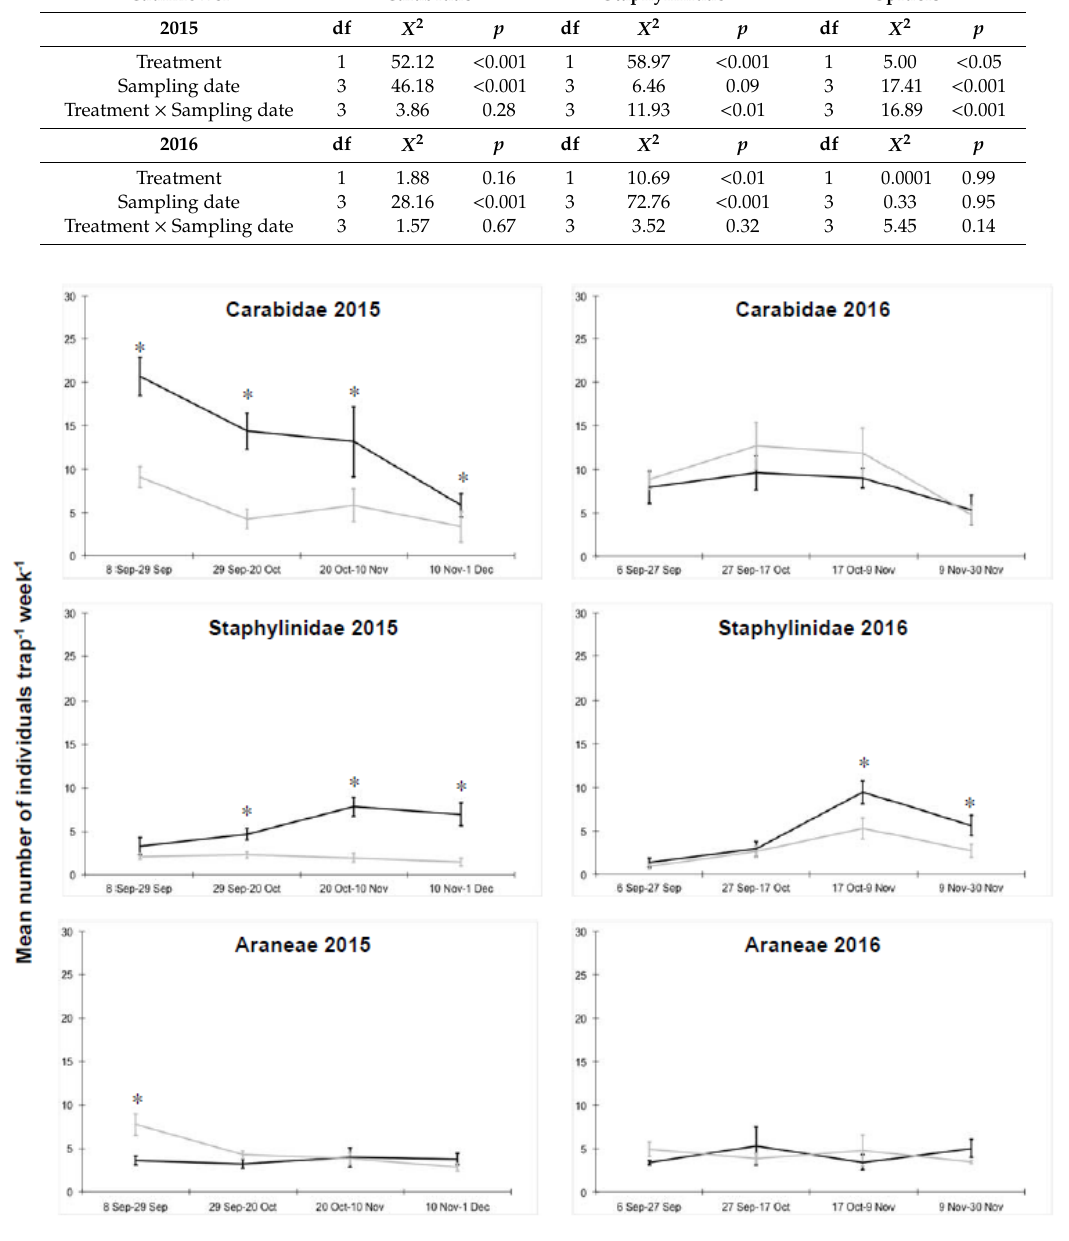
Table 1. Statistics of the model effect for the negative binomial General Linear Mixed Model carried out on the number of individuals Carabidae, Staphylinidae, and Araneae in cauliflower plots.